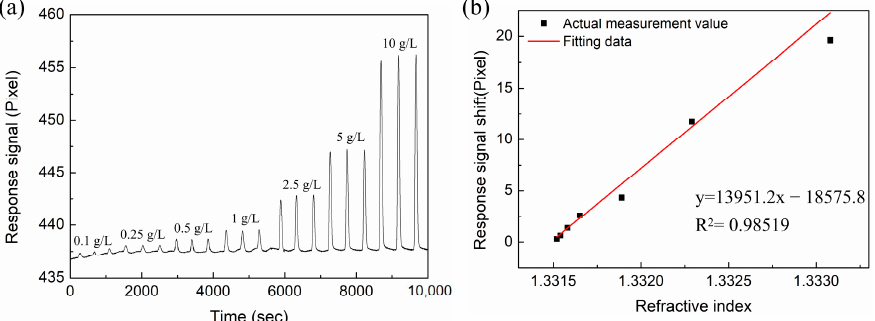
Figure 9. ( a ) The response curves of NaCl solution with different concentrations for the conventional Au-based biosensor. ( b ) The corresponding linear fitting line.